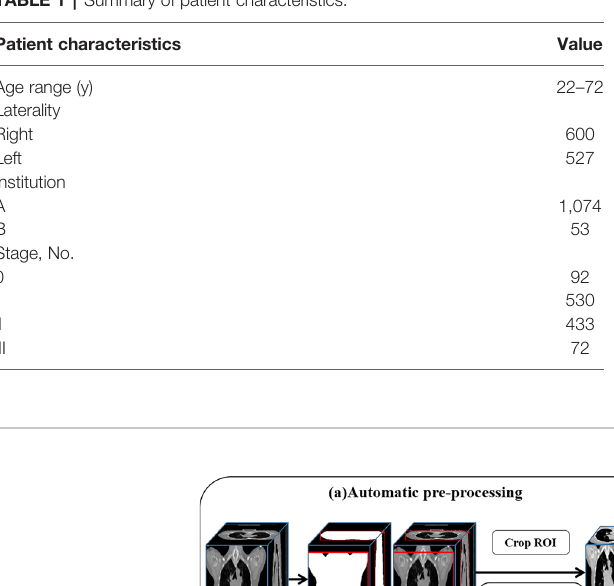
TABLE 1 | Summary of patient characteristics.